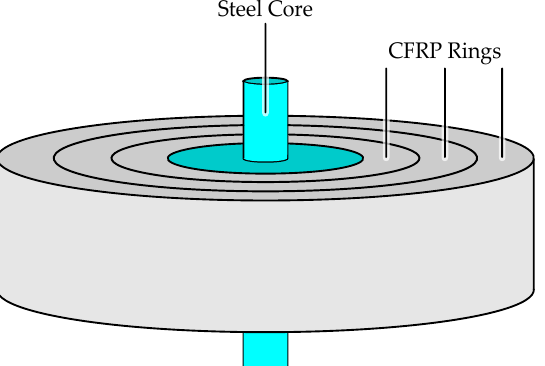
Figure 3. Construction of the flywheel. Three CFRP rings are press-fitted onto a steel core.